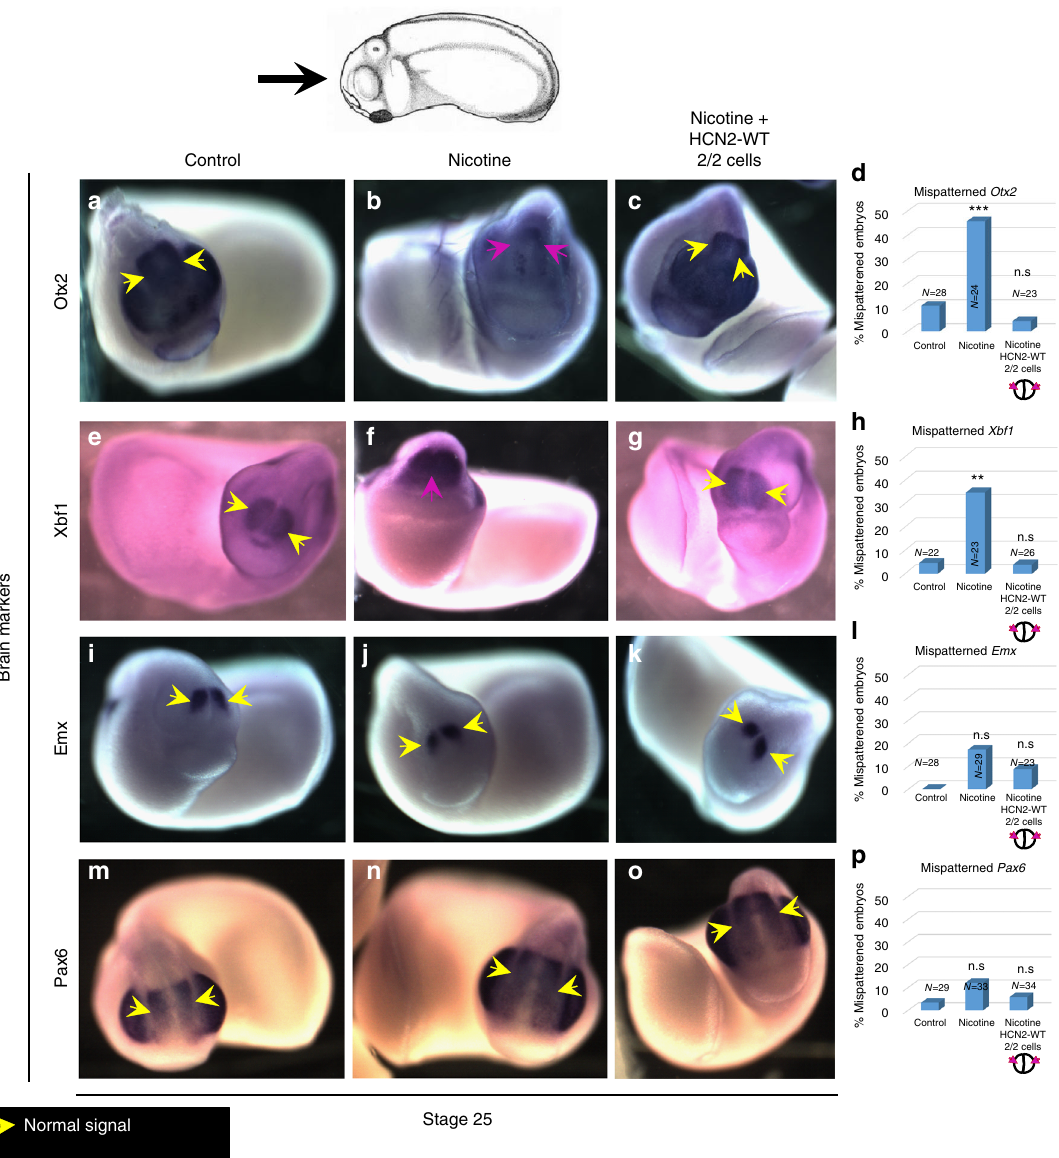
Fig. 8 HCN2 channels restore nicotine exposure induced mispatterning of brain markers during neural development. Stage 25 embryos as illustrated with the angle of view marked by the black arrow. Control (untreated/uninjected) embryos ( a , e , i , l ), embryos exposed to nicotine (0.1 mg/mL – stage 10 onwards) (b , f , j , n) , and nicotine-exposed embryos microinjected with Hcn2-WT mRNA (0.75 ng/injection) in both blastomeres at 2-cell stage ( c , g , k , o ). In situ hybridization for Otx2 ( a – d ), Xbf1 ( e – h ), Emx ( i – l ), and Pax6 ( m – p ) show that nicotine exposure leads to signi fi cantly mispatterned expression (magenta arrows) of Otx2 [46% n = 24] and Xbf1 [35% n = 23], but has little effect on Emx [17%, n = 29] and Pax6 [12%, n = 33] in comparison to controls [10%, n = 28, 4.5%, n = 22, 0%, n = 28, and 3%, n = 29, respectively]. Nicotine-exposed embryos that were also microinjected with Hcn2-WT mRNA showed largely normal expression of Otx2 [4% n = 23], Xbf1 [4% n = 26], Emx [9% n = 23], and Pax6 [6% n = 34] in comparison to built a model of bioelectric patterns of neural stage Xenopus brain speci fi c V mem pattern have already been shown to cause embryo, taking into account spatiotemporal dynamics of all dif- serious brain morphology defects 28 . In the model, HCN2 chan- nels were seen to behave in a unique context-speci fi c manner ferent parameters including gap junctions, tight junctions, and (Fig. 3f) that speci fi cally ampli fi es the differential neural tube relevant biochemical signals. V mem pattern across the neural plate despite the presence of The endogenous early embryonic V mem patterns across the neural tube are required for normal brain development 28 . Nico- nicotine ( fi tting the functional criteria of the model-derived IT). tine, an ion channel ligand, disrupts brain patterning (Fig. 1). We This predicts that context-speci fi c action of HCN2 would analyzed the BETSE model to understand how nicotine and IT strengthen the V mem pattern otherwise diminished by nicotine actions would integrate at the level of embryonic V mem pattern- and thus restores downstream transcription factors and brain patterning. Precisely, this was observed in our physiological ing, and generate predictions and testable hypotheses. pro fi ling experiments (Fig. 4). It is also important to note that the Nicotine exposure diminished the endogenous neural tube model predicts that due to its context speci fi c action, HCN2 hyperpolarization in the model (Fig. 3). Such disruptions in the